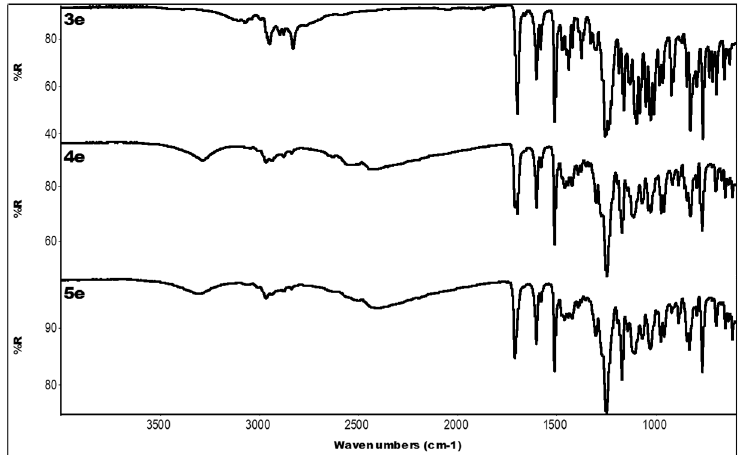
Figure 7. IR spectra of base 3e (R = 4-OCH 3 ) and protonated compounds 4e (R = 4-OCH 3 , equivalent of HCl) and 5e (R = 4-OCH 3 , excess HCl).